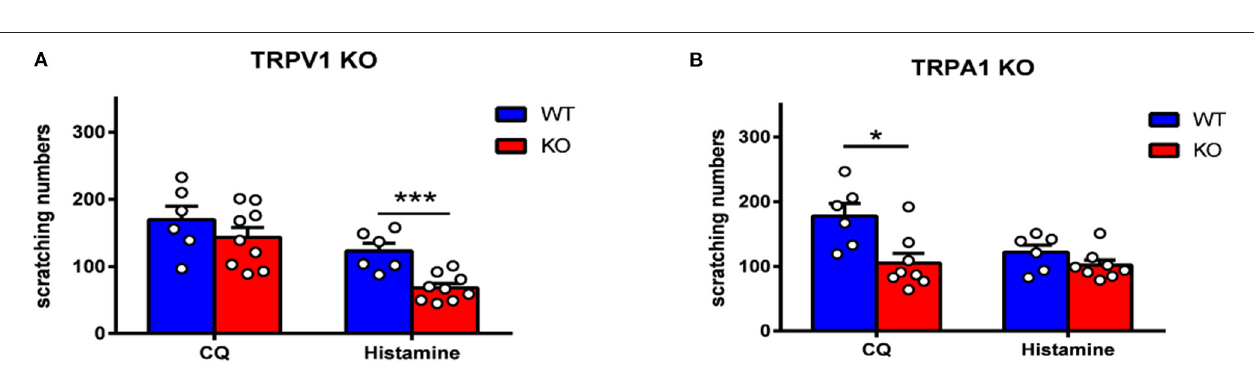
FIGURE 7 | Itch behavior was attenuated in TRPV1 KO and TRPA1 KO mice. (A) Histamine-induced scratching was reduced dramatically in TRPV1 KO mice ( t -test, *** p < 0.001 vs. the WT group). (B) CQ-induced scratching was reduced dramatically in TRPA1 KO mice ( t -test, * p < 0.05 vs. the WT group). N = 6-9 for each group.